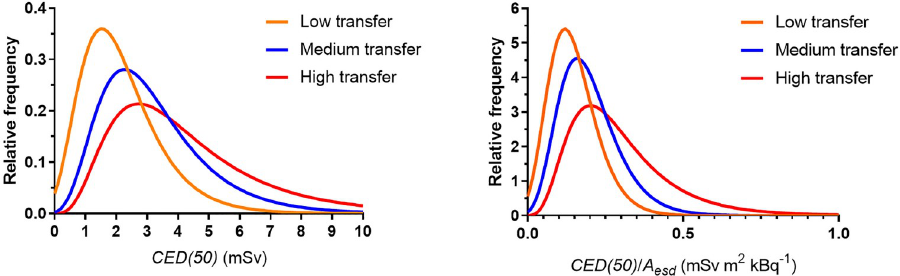
Fig 9. Distribution of CED(50) (left) and CED(50) / A esd (right) for adult males, fitted by lognormal distributions. The curves representing medium transfer (standard scenario) were calculated by Monte Carlo simulation with T 11, while the low-transfer and high-transfer curves were calculated using T ag(max) = 1 and T ag(max) = 30,